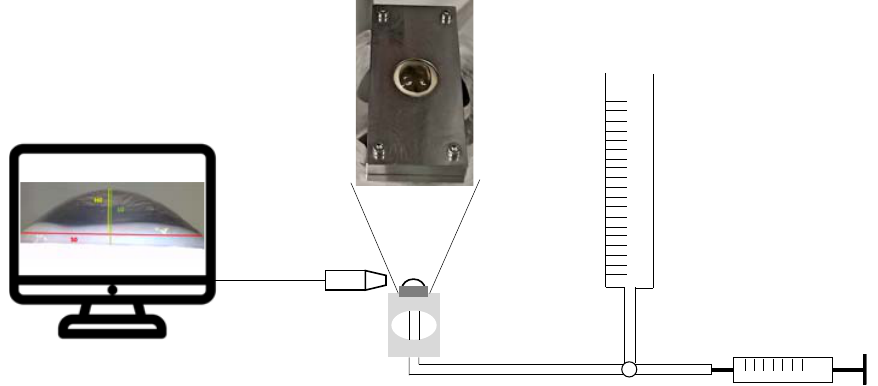
Figure 2. Scheme of the inflation tests experimental setup used to evaluate corneal stiffness.